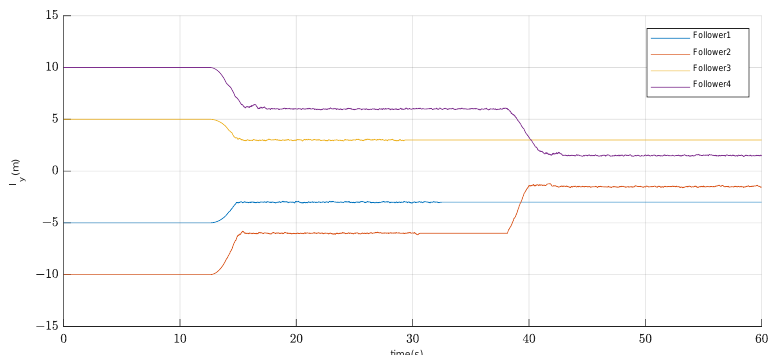
Figure 24. The variation curves of l x for each follower during the movement.